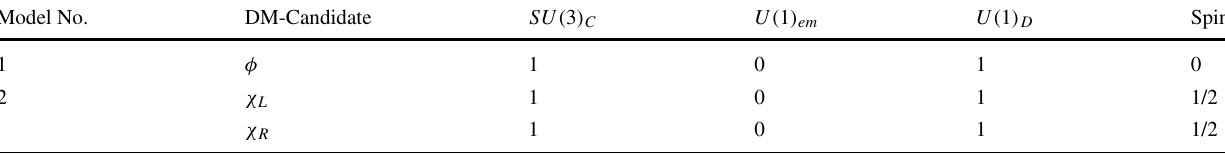
Table 43 Quantum numbers of various Dark-Matter fields under the broken SM gauge groups extended by U ( 1 ) D Model